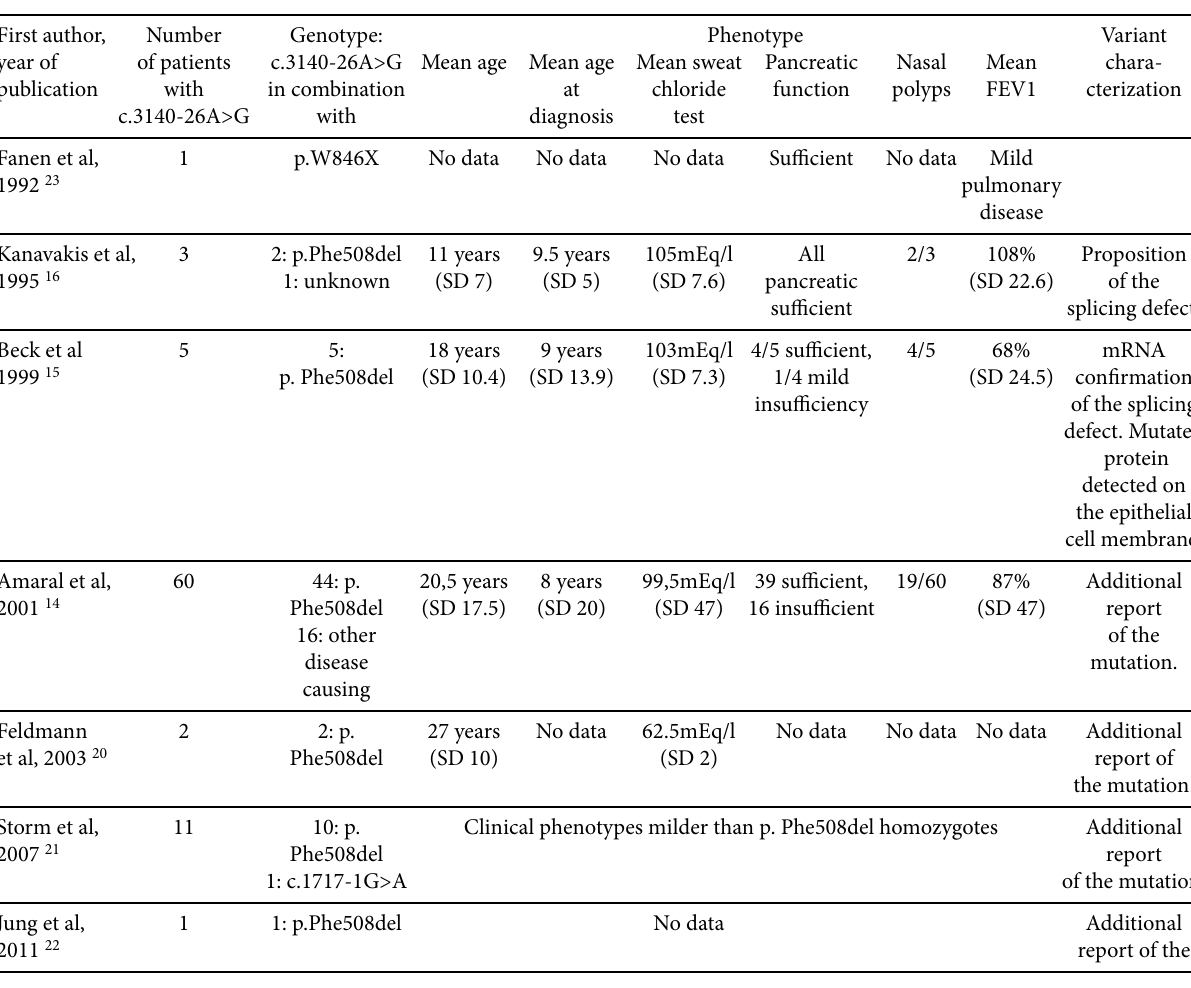
Table 4. Clinical characteristics of the in the published literature found reports of patients with the c.3140-26A>G mutation and chronological char- acterization of the variant. 14-16,